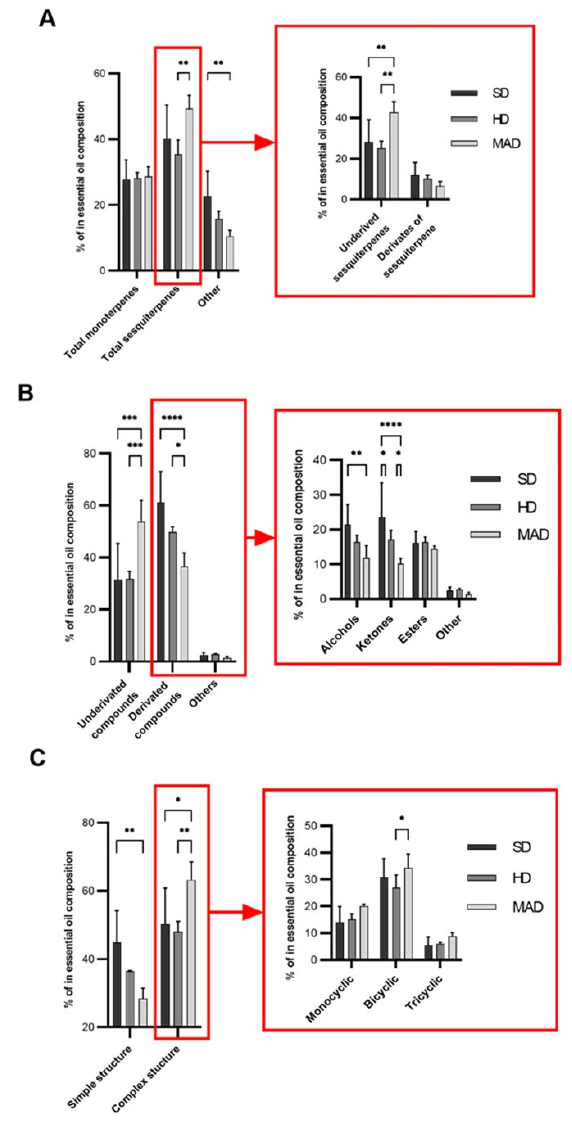
Figure 3. Application of three different distillation methods (SD–steam distillation, HD– hydrodistillation and MAD–microwave-assisted distillation) induces changes in isolated terpene composition, functional groups and compound structural complexity. ( A ) Total amount of monoterpenes, derived monoterpenes, sesquiterpenes, derived sesquiterpenes and other compounds identified in EOs. ( B ) Total amount of underived and derived compounds identified in EOs with further subdivision of derived compounds onto alcohols, ketones, esters and others. ( C ) Total amount of compounds with simple (acyclic) and complex (at least one ring in the structure) compounds identified in EOs. Complex compounds were further divided into monocyclic, bicyclic and tricyclic compounds. * for p < 0.05, ** for p < 0.001, *** for p < 0.0001, and **** for p <